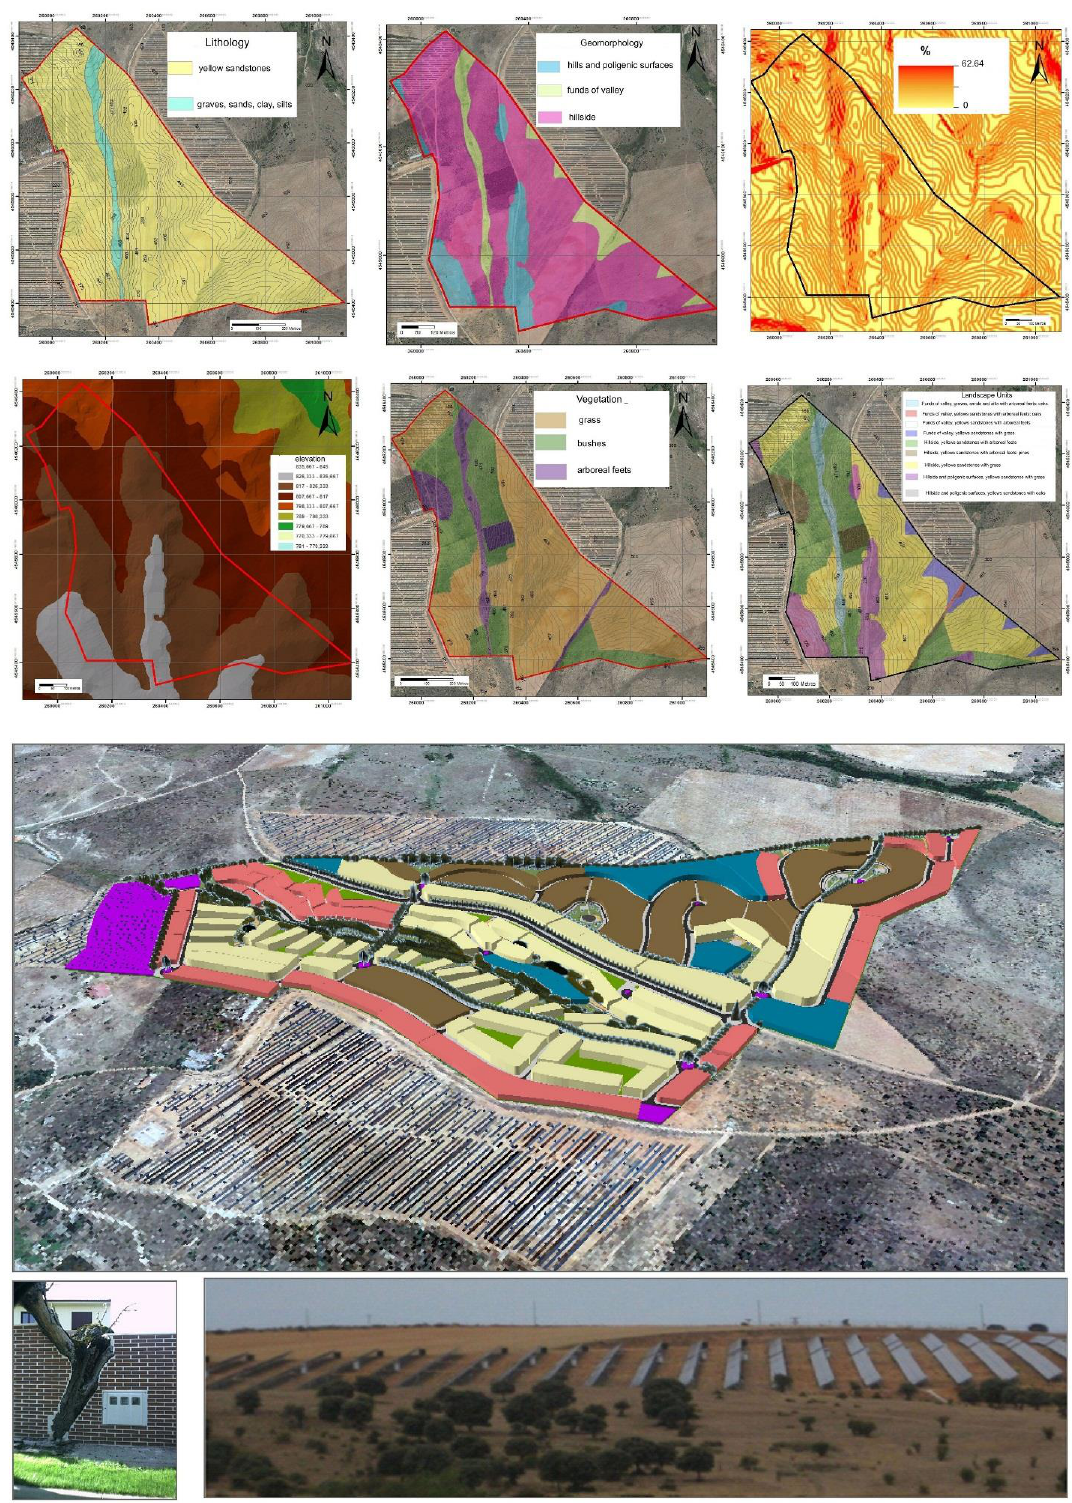
Figure 4. Determination of the landscape units by indirect methods and extrusion 3D with solar parks.